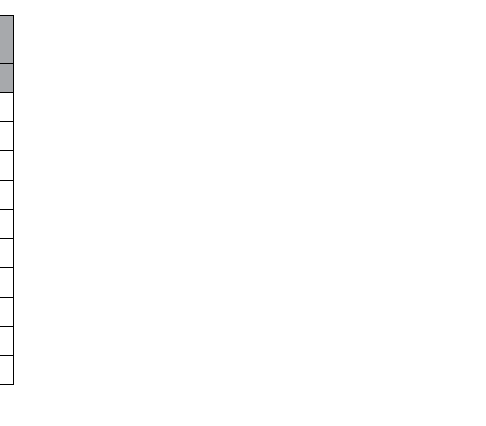
Table 9. Numerical analysis results for Model 2 and